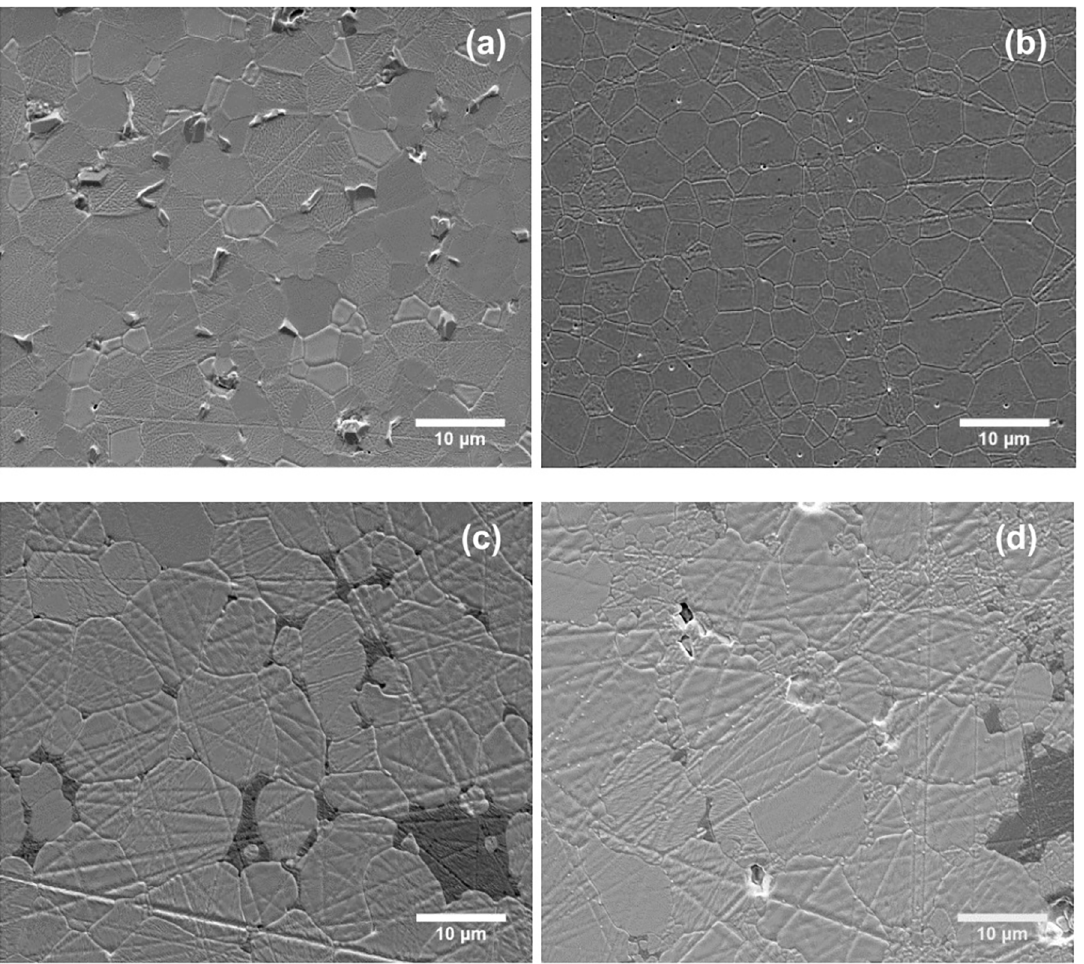
Figure 4. FEG-SEM micrographs of (a) LSGM, (b) 8YSZ, (c) 10 wt.% and (d) 20 wt.% 8YSZ added to LSGM.